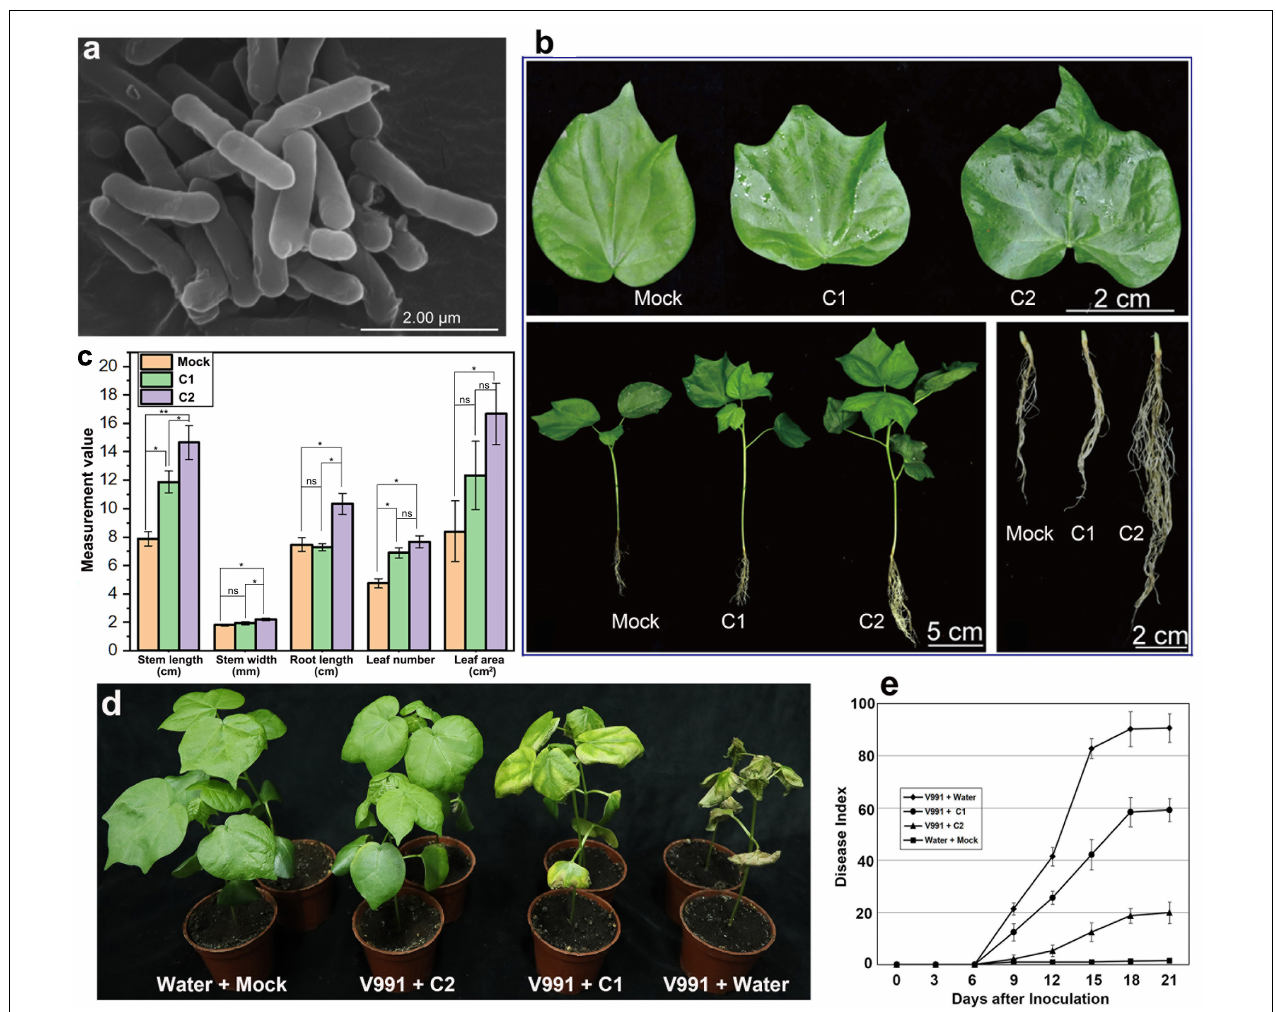
FIGURE 1 | Morphological characteristics and phenotypic changes in cotton seedling 30 days after inoculation of GN03. (a) Scanning electron microscopic image of the bacterial cell after culture for 16 h at 37 ◦ C. (b) The phenotype of the leaf, whole plant and root in cotton seedlings 30 days after inoculation of GN03. (c) The biomass of cotton seedlings. Leaf area is measured as the area of the third leaf from the top bud. Statistical significance was evaluated by one-way ANOVA and LSD post hoc test (* p < 0.05, ** p < 0.01; ns, not significant, n = 30). (d) Disease symptoms of cotton plants pre-treated with different concentrations of GN03 (0, 10 4 , and 10 8 cfu/mL) following inoculation with V. dahliae strain V991 at 18 dpi. (e) Disease indexes of the GN03-pre-treated cotton were determined from 3 to 21 dpi. Values are means ± SD; n =